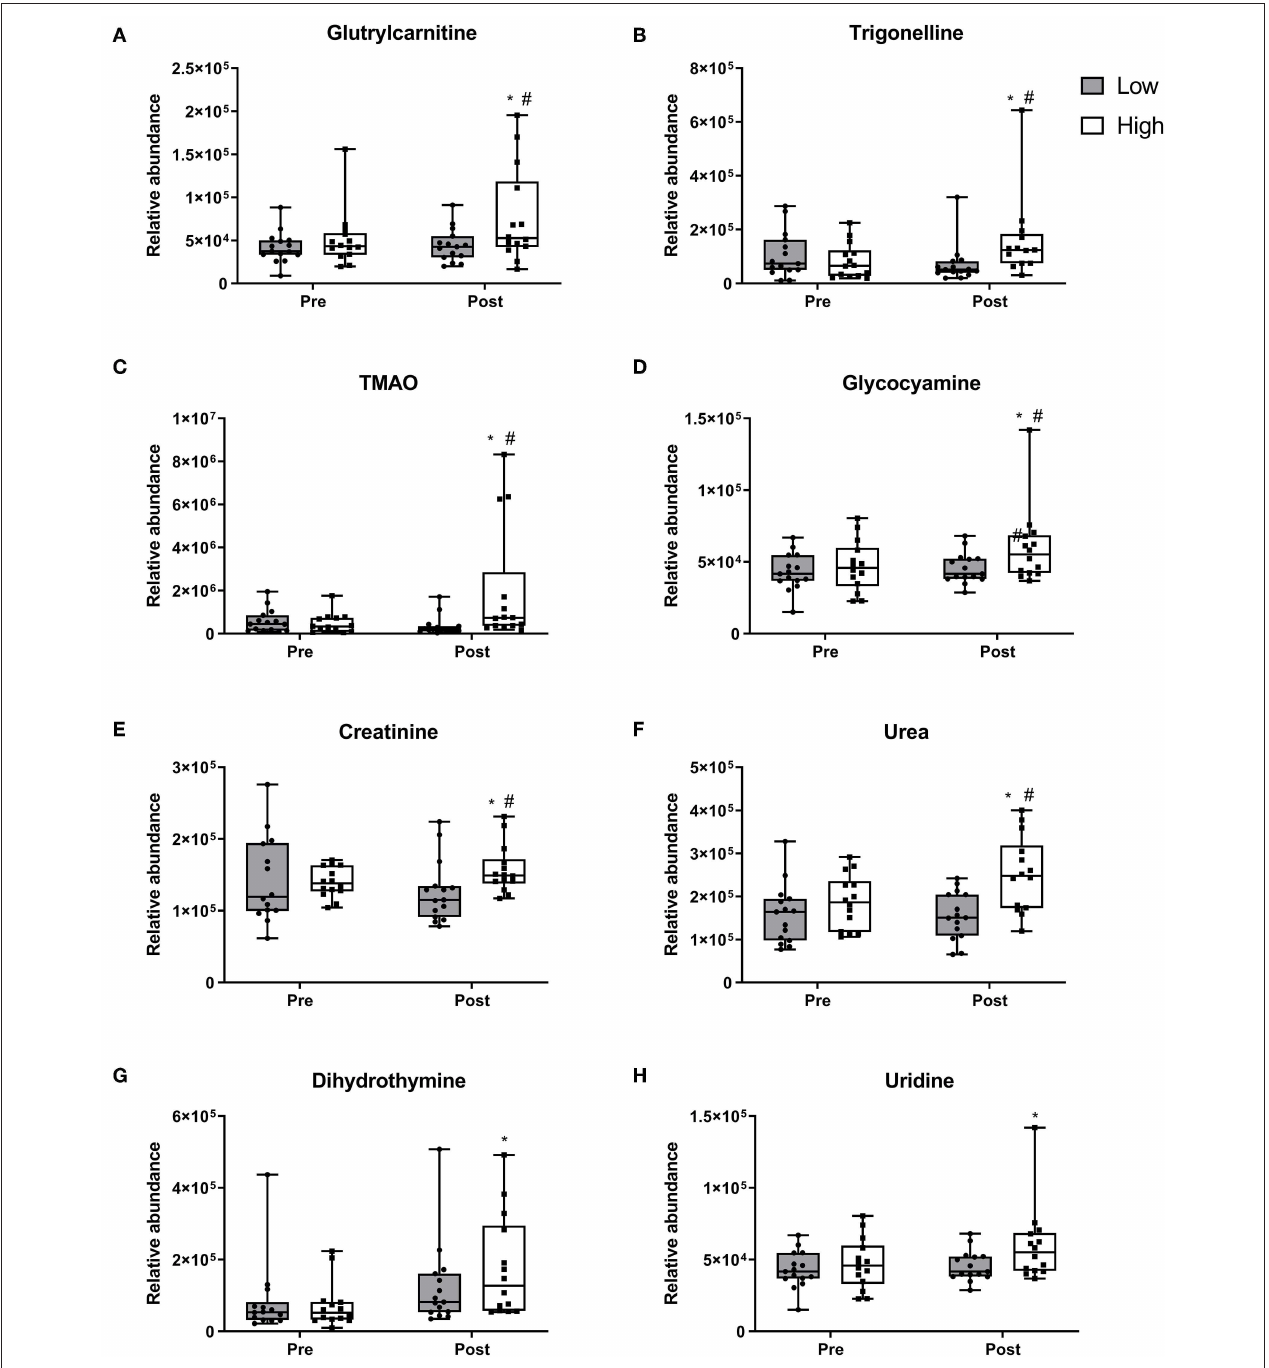
FIGURE 2 | Metabolites which increased in the 2RDA diet. Box and whisker plot showing median, first, and third quartiles, and maximum and minimum values. (A) glutrylcarnitine, (B) trigonelline, (C) TMAO, (D) glycocyamine, (E) creatinine, (F) urea, (G) dihydrothymine, and (H) uridine increased within the 2RDA group. # denotes the significant differences of metabolites between 2RDA and RDA. *Represents the significant differences of metabolites between pre and post intervention within each group. Arginine and Proline Metabolism metabolites with fold changes ranging between 1.2 and 2.7. Greatest statistical discrimination between the diets related to arginine and proline pathways, which comprised of eight